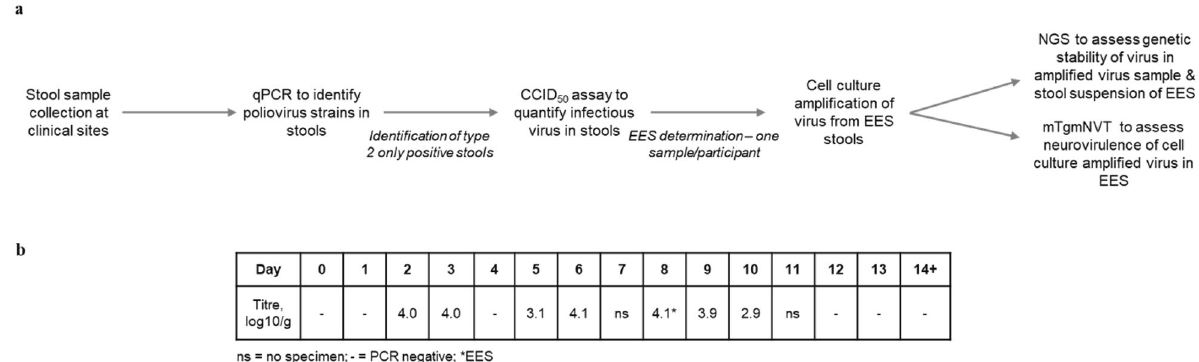
Fig. 1 Overview of stool sample analysis and EES identi fi cation. a Genetic stability work fl ow. b EES selection. Hypothetical CCID 50 /g data from a clinical participant, to demonstrate selection of the